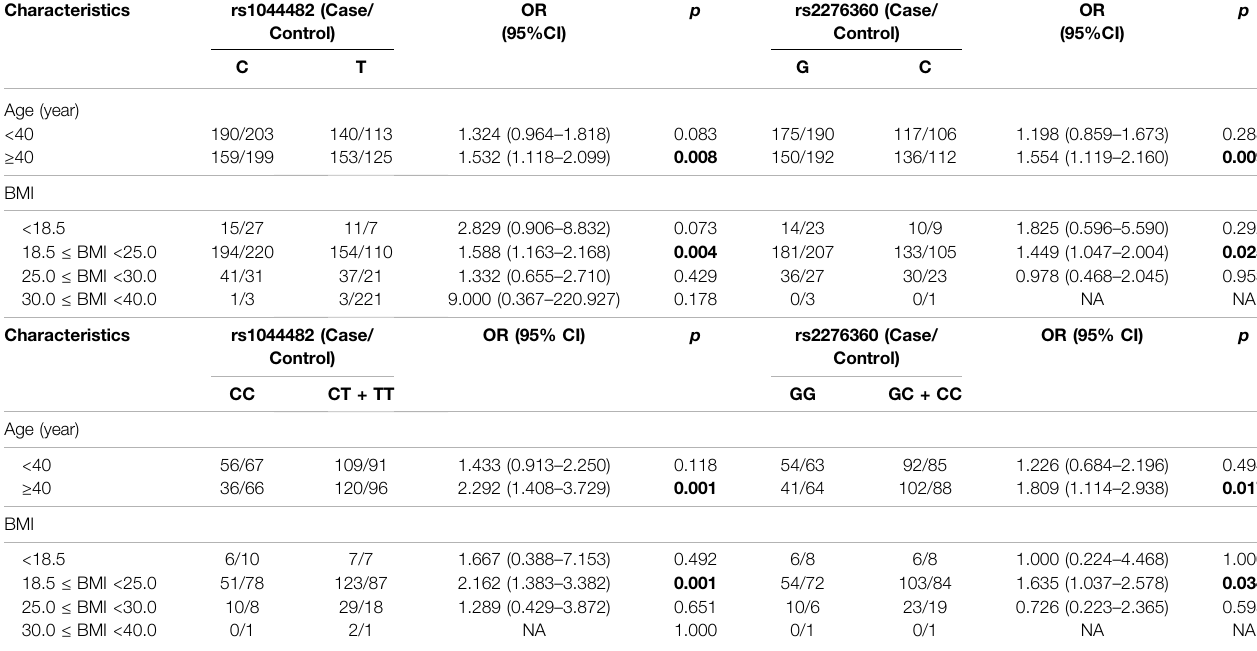
TABLE 4 | Strati fi cation analysis of risk alleles and genotypes with ULs susceptibility.